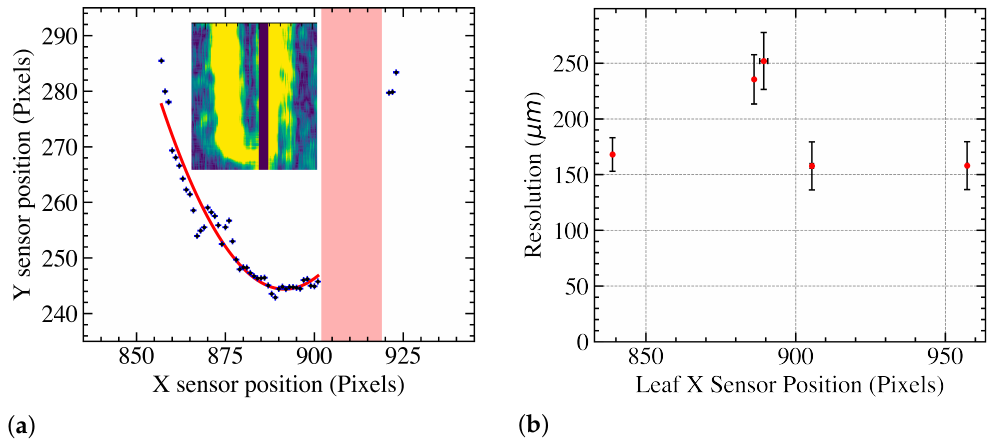
Figure 7. Reconstructed leaf edge over sensor gap and fit to determine leaf position. Sensor gap is overlaid in red. The inset shows the Sobel output around the leaf including the sensor gap (not at the same scale) ( a ). Leaf edge resolution for a leaf sweeping across the sensor gap ( b ). For approximately x = 886, 889 and 905 pixels, the gap covers the left, the middle and the right part of the